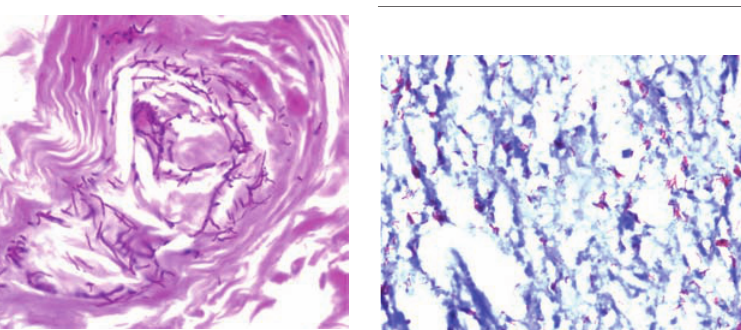
Figure 3. A) Photomicrograph showing ulcerated intestinal mucosa with dense inflammatory cell infiltration (Haemato - xylin and Eosin x 100); B) dense infiltra- tion by neutrophils and lymphocytes, in the intestinal wall (Haematoxylin and Eosin x 400).